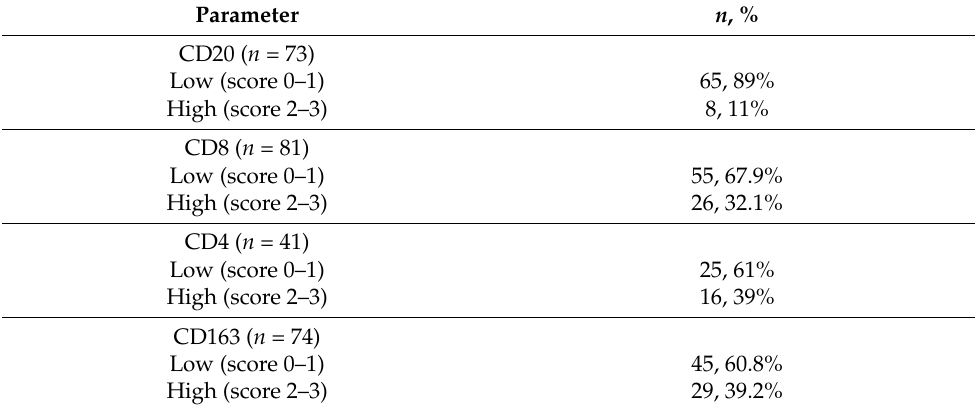
Table 2. Immunohistochemical